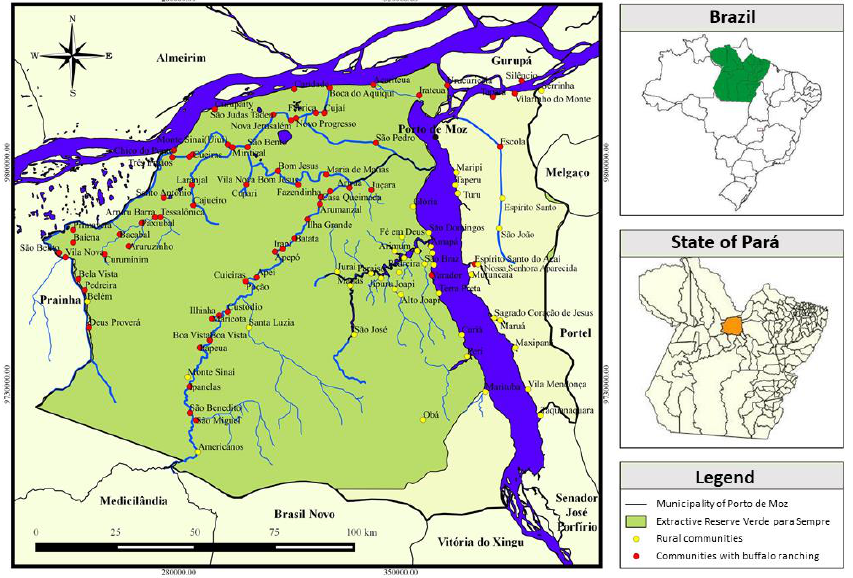
Figure 1. Communities with buffalo ranchers in the municipality of Porto de Moz. Source: Field- work.